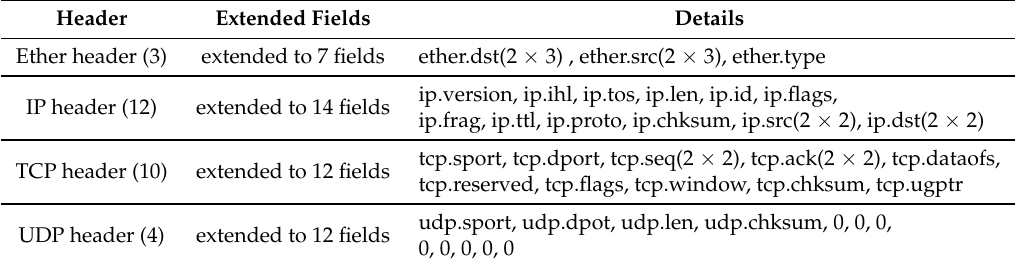
Figure 2. The illustration of the packet-word-transfer mechanism. Table 3. Packet header(tcp:25, udp: 19) fields, extended fields (tcp: 33, udp: 33) and the length of the